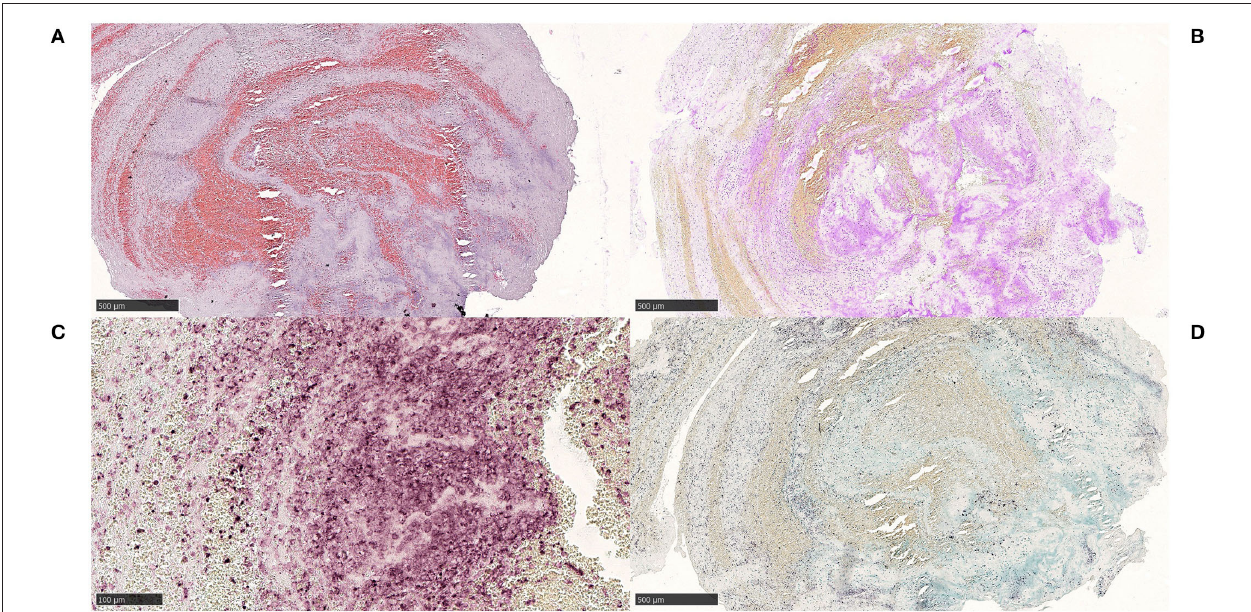
FIGURE 4 | Extracellular DNA (ecDNA) without morphologically evident calcifications. Case 1.4 Webs of acellular basophilic material surrounding platelets and intermixed with red blood cells (A) H&E, 50x. A Feulgen stain confirmed the DNA content within this basophilic compartment, and it was regarded as ecDNA (B) Feulgen, 50x. Lymphocytic and neutrophilic cells in varying stages of degeneration, as well as shadows of necrotic cells were seen within the ecDNA in H&E (not shown). Immunohistochemically, the ecDNA, as well as the membranes of most viable cells, showed immunoreactivity for the pan-leukocytic marker CD45, indicating a leukocyte origin of the ecDNA (C) CD45, 200x. However, citrullinated H3 (H3Cit), a marker of neutrophil extracellular traps, did not stain the ecDNA, which suggests a non-neutrophil source (D) H3Cit, 50x. The stroke etiology and the underlying pathophysiological events are not evident. For 50x, scale bar = 500 µ m; for 200x, scale bar = 100 µ